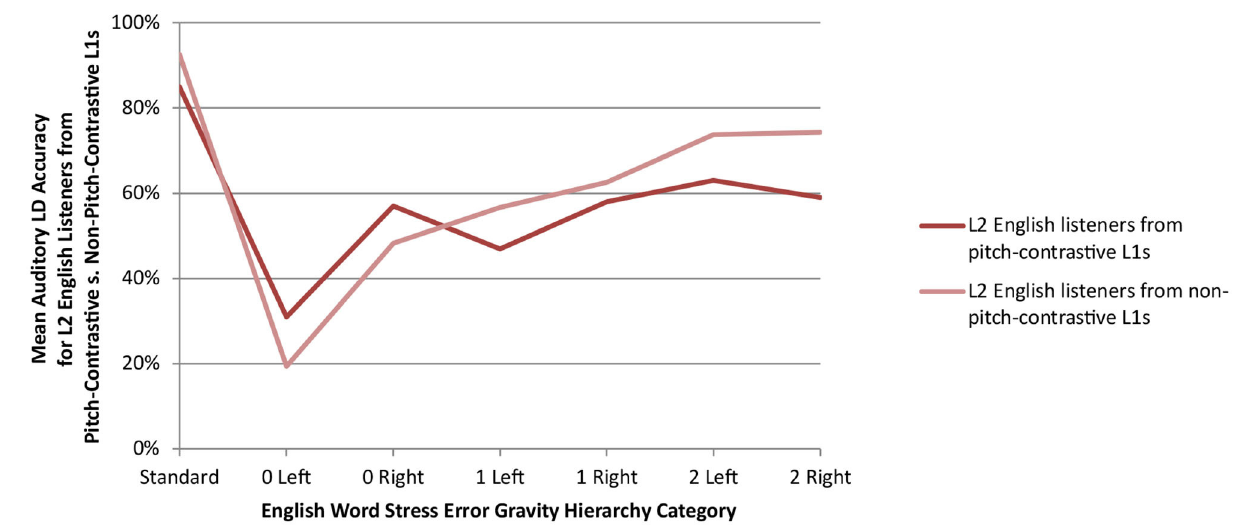
FIGURE 6 | Mean auditory LD accuracy for L2 English listeners’ from pitch-contrastive L1s ( n = 17) and non-pitch-contrastive L1s ( n = 14) by Hierarchy